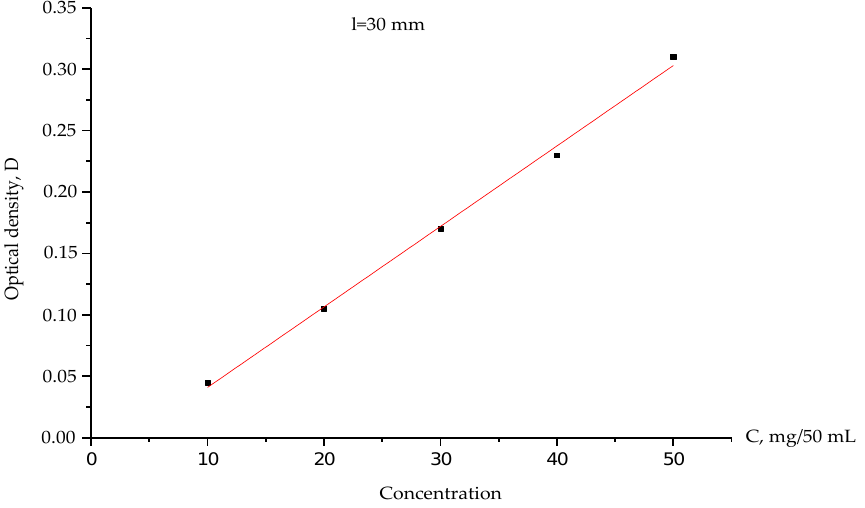
Figure 2. The calibration curve for determining the concentration of cerium (III) in the test solutions. The optical density (D) of the formed cerium ions complex in the solutions was determined by the Jenway-6305 spectrophotometer. The calibration curve was plotted using the Origin software (r 2 value is 0.99605, D = 0.0655C − 0.0245).